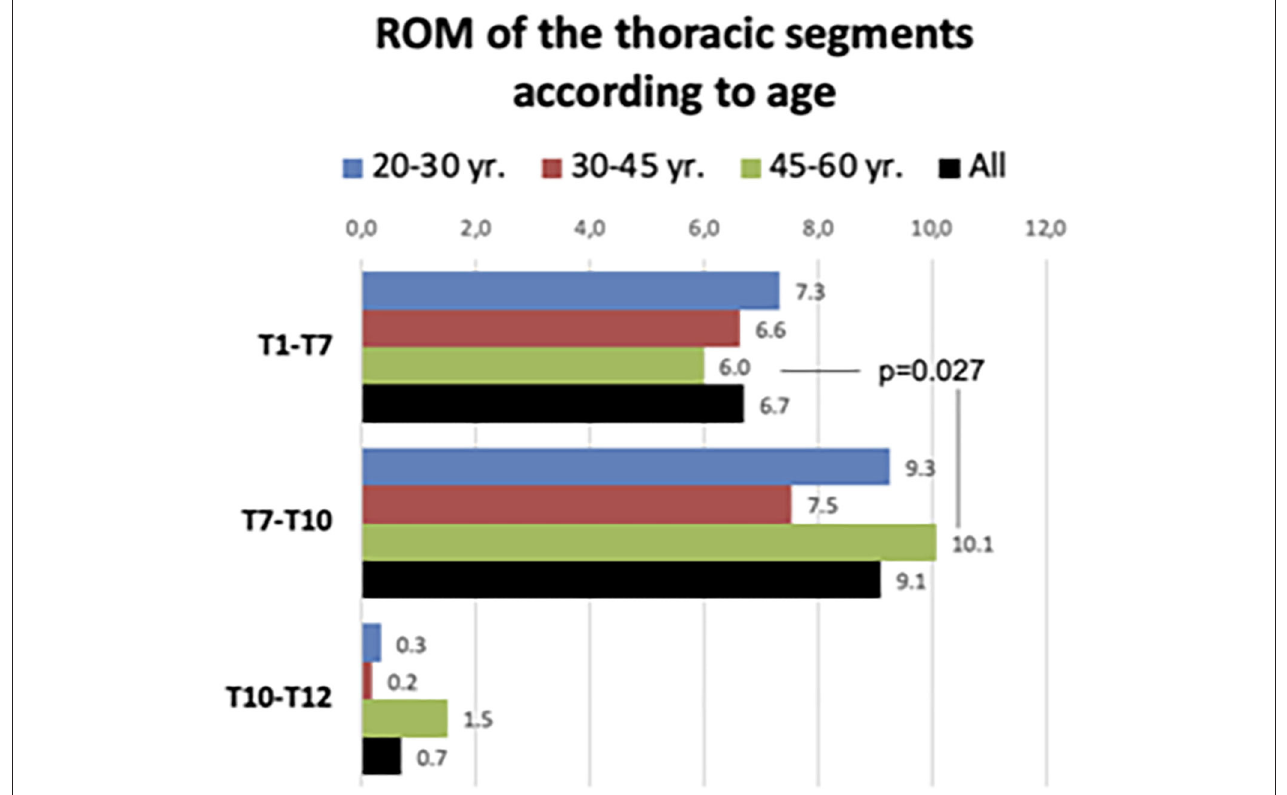
FIGURE 5 | Range of motion of the three main thoracic segments in the whole sample and according to age